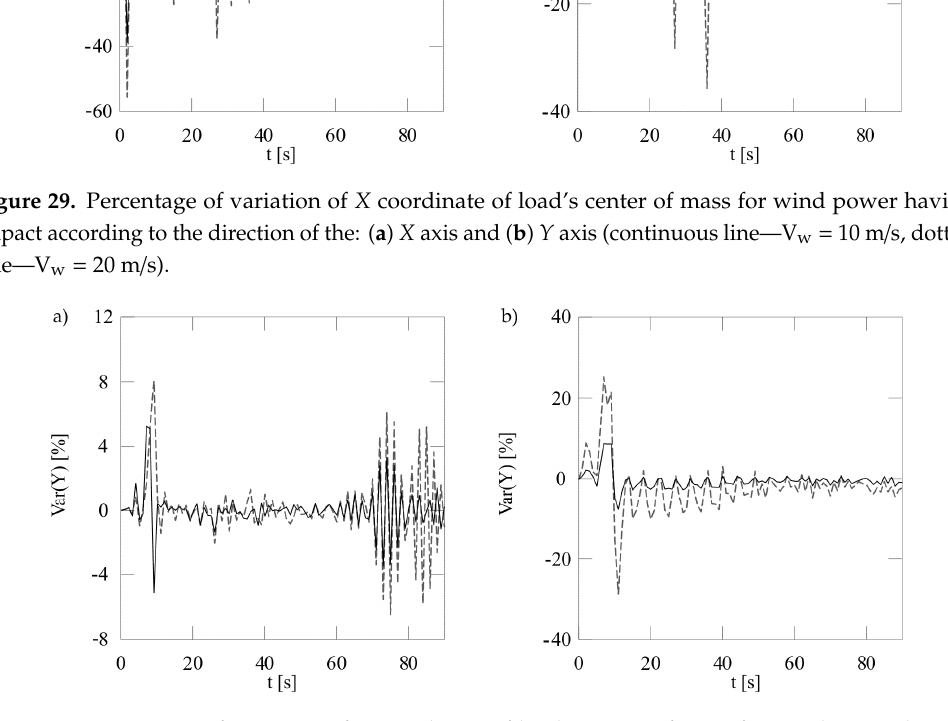
Figure 30. Percentage of variation of Y coordinate of load’s center of mass for wind power having impact according to the direction of the: ( a ) X axis and ( b ) Y axis (continuous line—V w = 10 m/s, dotted line—V w = 20 m/s).